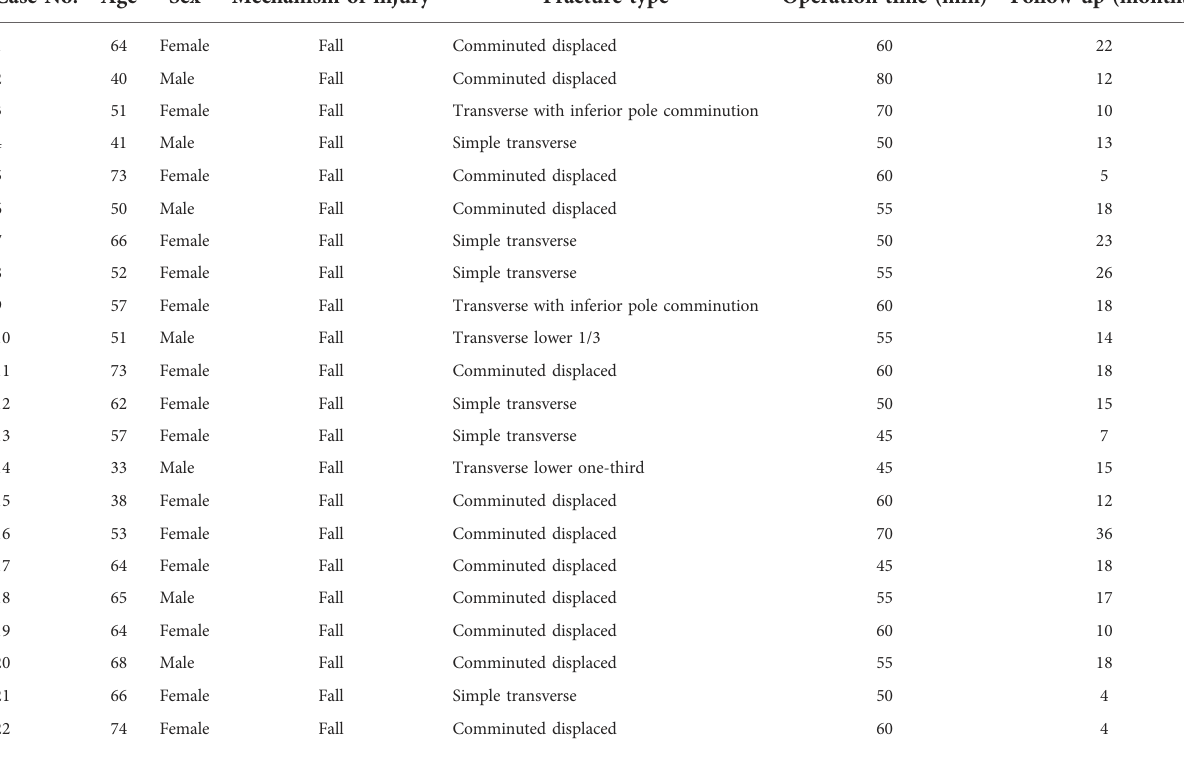
TABLE 1 Patients